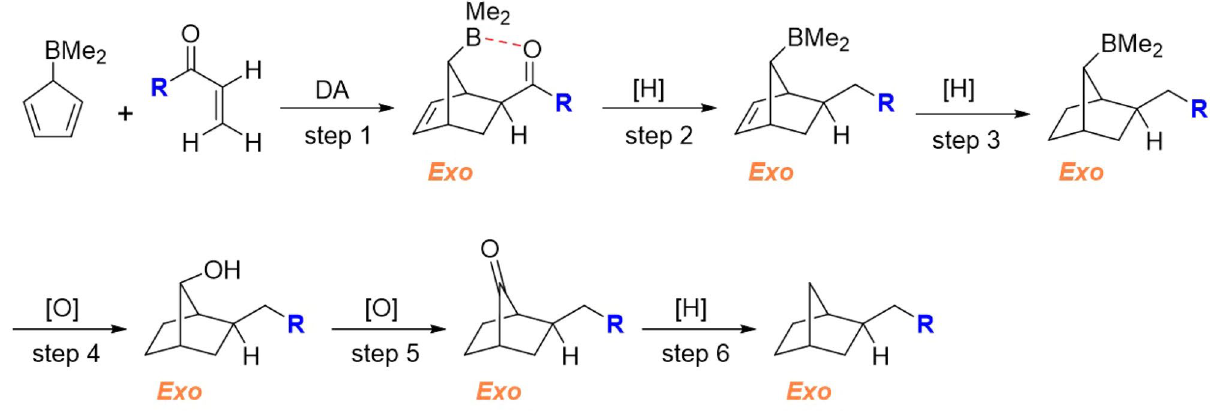
Figure 7. A proposed synthetic route for the stereoselective synthesis of exo-2-alkylbicyclo[2.2.1]heptanes. The red dashed line indicates the LAB